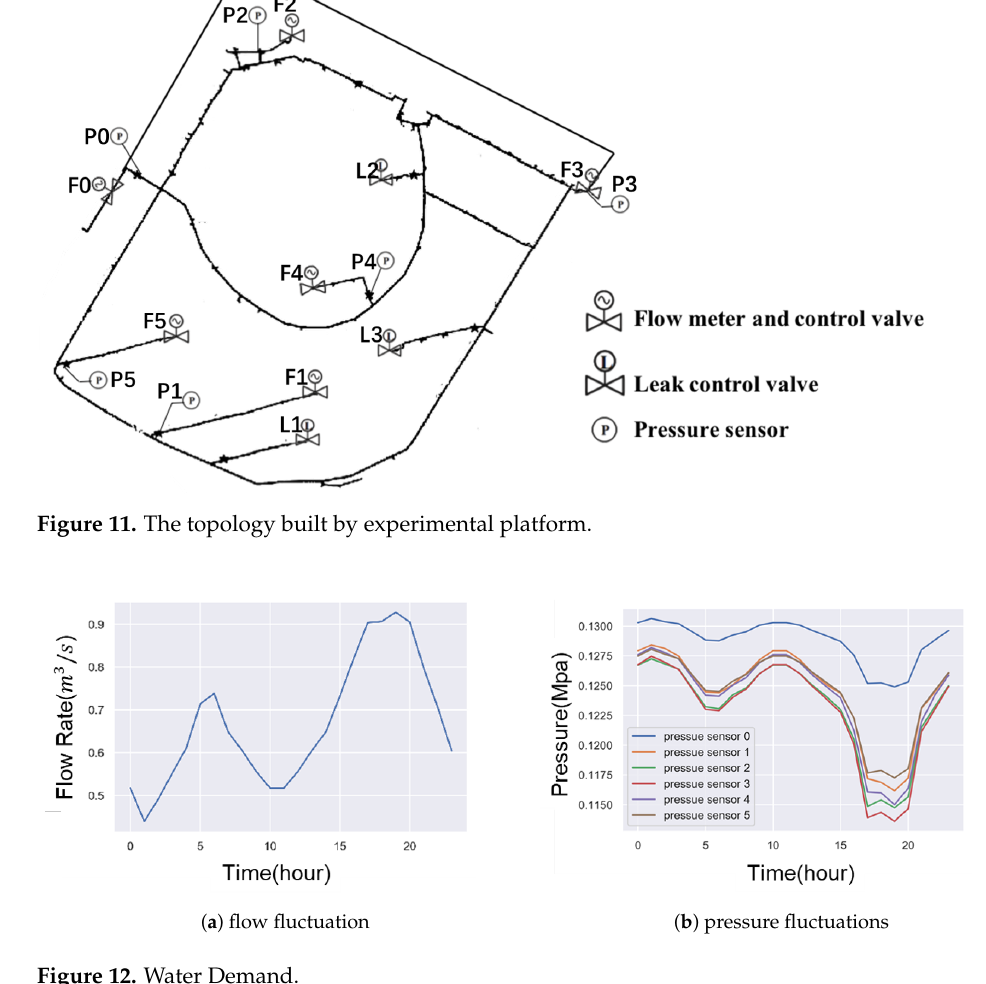
Figure 12. Water